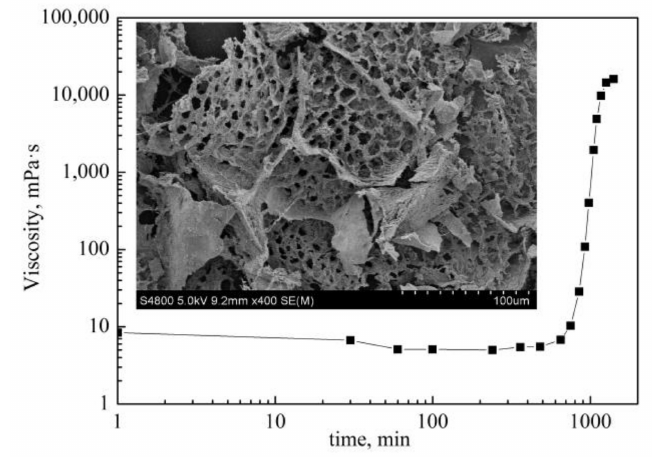
Figure 1. The curve of viscosity with time under static gelation in ampoule bottle.